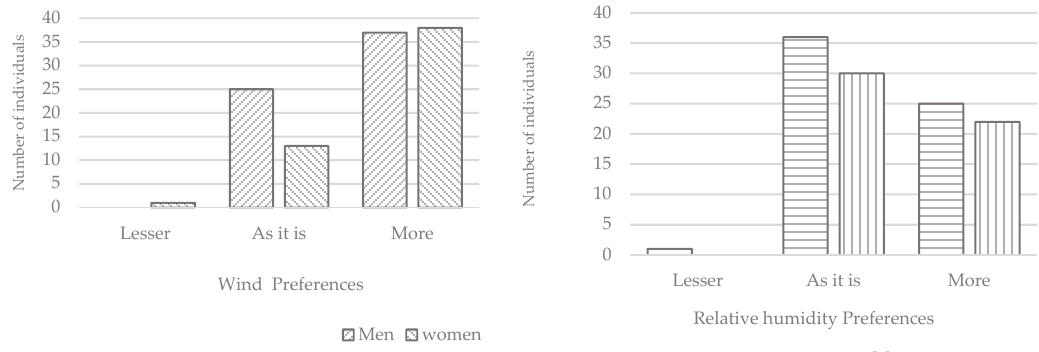
Figure 6. Percentages of preferences votes in summer. Age Differences Table 3 presents the demographic distribution of age and gender between the two groups (192 females and 192 males). The numbers and percentages of the interviewees were 114 (29.7%) in the summer and 270 (70.3%) in the winter. Among all the subjects, young people (<30) had a ratio of 67.7% (183) in the winter and 68.42% (78) in the summer. In the analyzed sample, according to the Chi-square test, there is no significant relationship between respondents’ age and gender ( p = 0.24, ( p > 0.05). Between different age ranges in both summer and winter, the 25–30 range had the highest neutral status. The most votes were related to the cold and cool in winter and slightly warm and warm in the summer (Figure 7). Table 3. Descriptive analysis of age and gender. The sampling distribution was equal between two groups of men and women. Chi-square test showed that there is no significant relation between respondents’ age and gender ( p = 0.24, ( p > 0.05)).